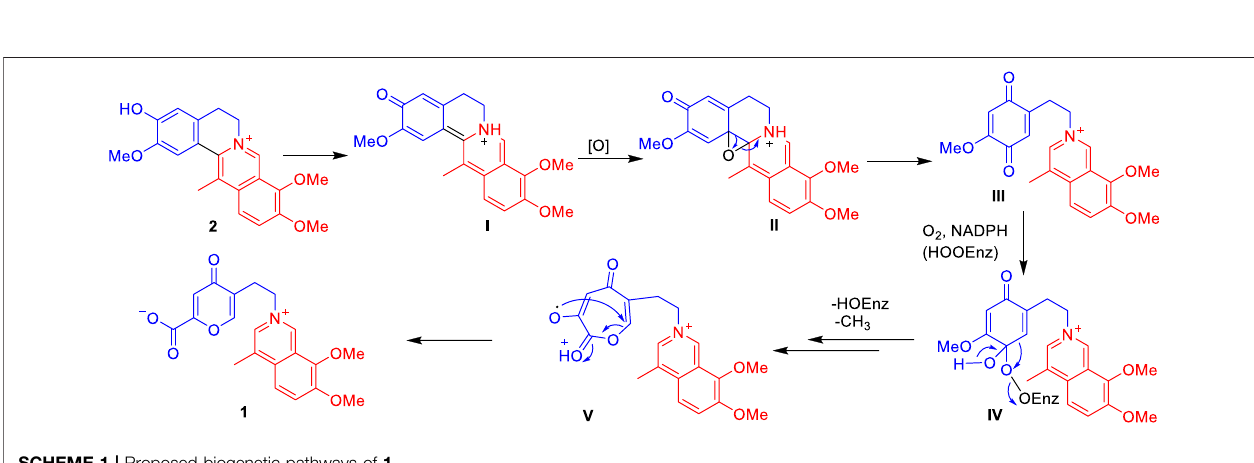
SCHEME 1 | Proposed biogenetic pathways of 1